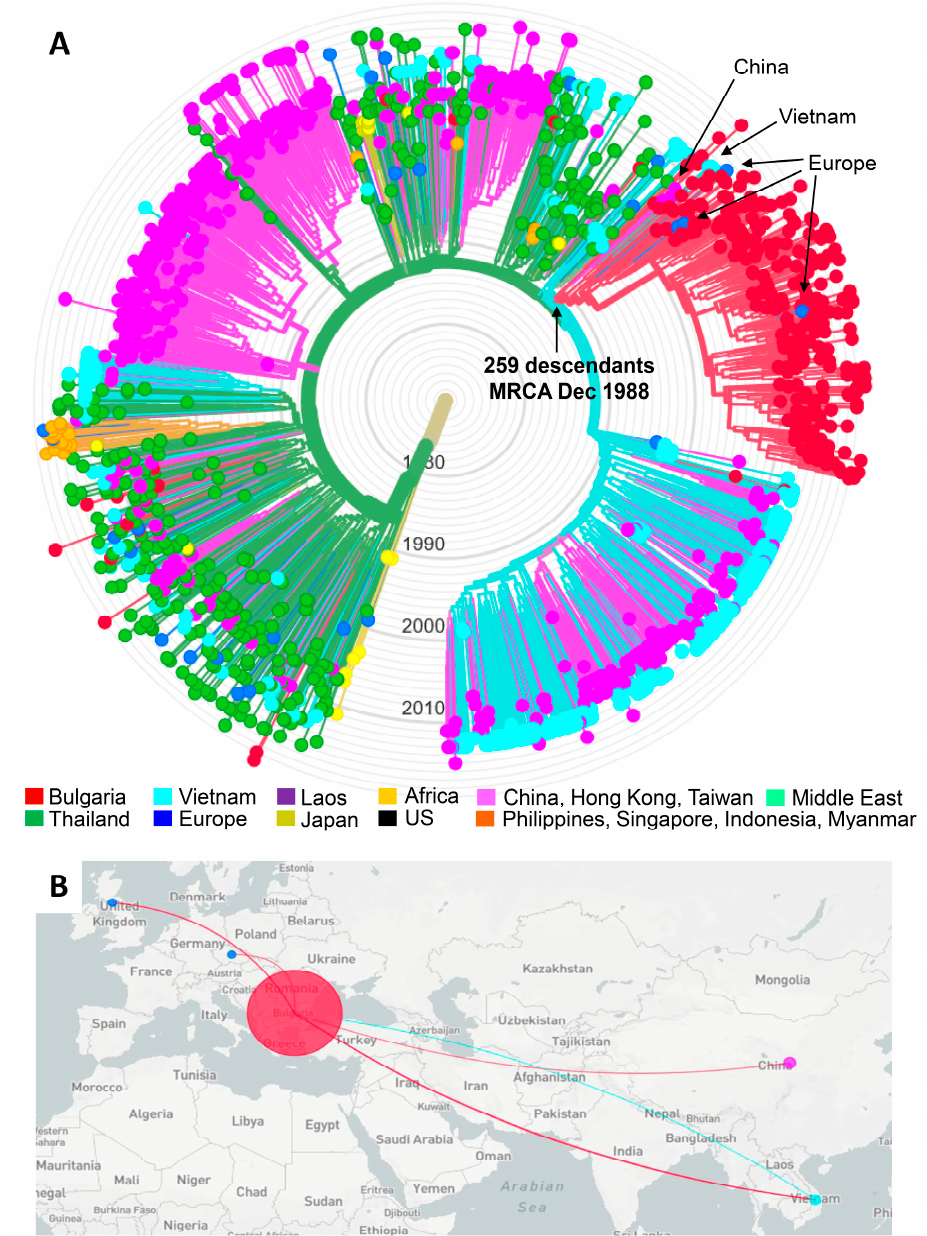
Figure 3. Nextstrain maximum-likelihood (ML) analysis of global HIV-1 CRF01_AE sequences. ( A ) The ML tree was constructed using 270 sequences from Bulgaria and 1458 global CRF01_AE sequences, including two from Bulgaria from a different study, 7 from Africa (Cameroon = 5, the Central African Republic = 2), 544 from China, 1 from Hong Kong, 3 from Taiwan, 20 from Europe (Belgium = 2, Czech Republic = 2, Finland = 1, France = 1, Slovenia = 1, Sweden = 7, the United Kingdom = 6), 276 from Vietnam, 49 from Laos, 362 from Thailand, 19 from the Philippines, 2 from Singapore, 3 from Indonesia, 2 from Myanmar, 6 from the United States, and two from the Middle East (Afghanistan = 1, Iran = 1). Three reference subtype J sequences were used as the outgroup. Tree branches are colored by country of birth as provided in the key. The arrows show the Bulgarian outbreak cluster showing inferred dating of the most recent common ancestor (CI, confidence interval). ( B ) Inferred geographical transmission routes with potential origins indicated by colored lines connecting countries, as provided in the ( A ).